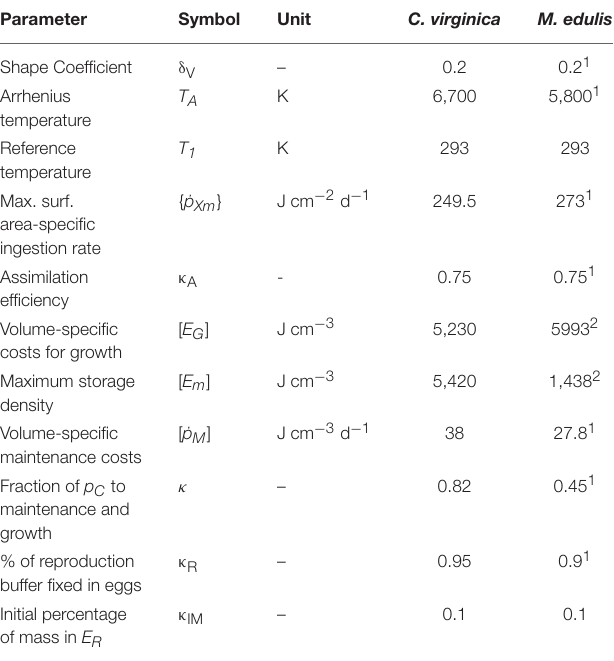
TABLE 2 | Standard DEB parameters for Crassostrea virginica (from Lavaud et al., 2017 ) and Mytilus edulis (from Rosland et al., 2009 1 ; Saraiva et al., 2011 2